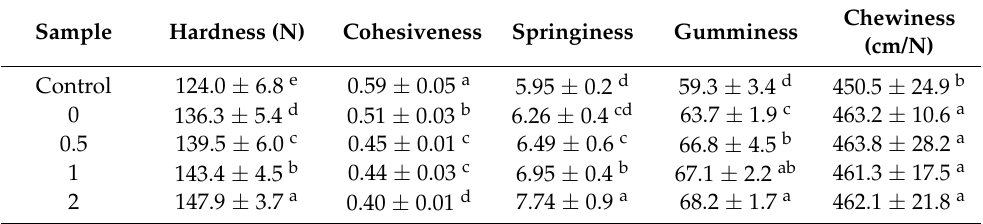
Table 3. Textural characterizations of the control sample and low-fat beef burger supplemented with different concentrations of LMWCH